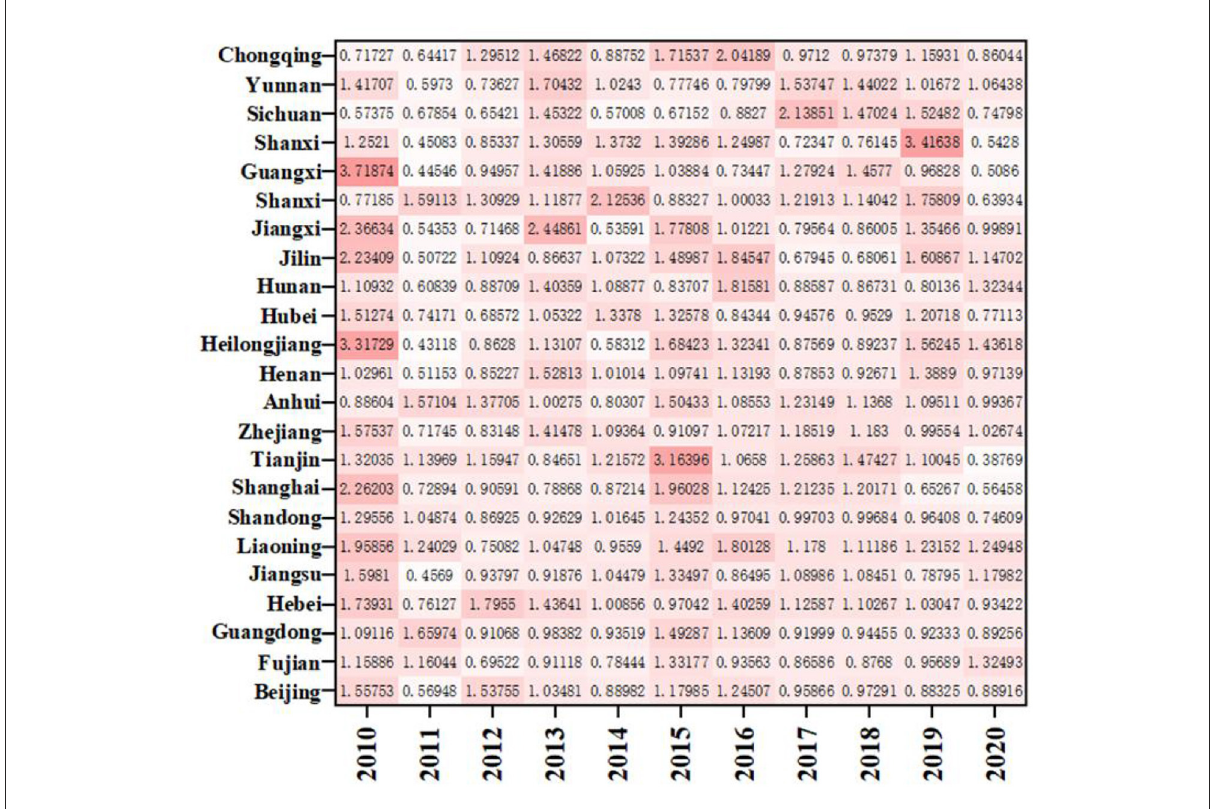
FIGURE7 EETS in different provinces from 2010 to 2020.